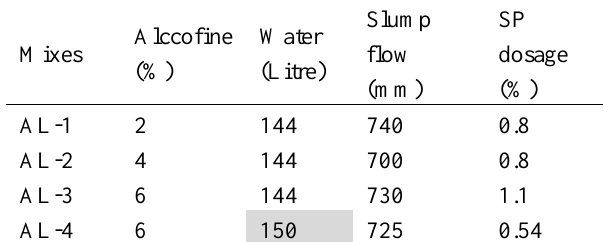
Slump results and SP dosage of Alccofine mixes